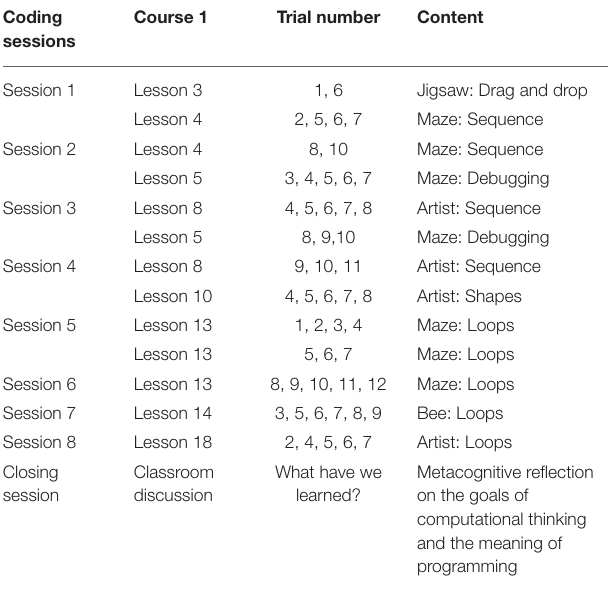
TABLE 2 | Lessons plan. Selected coding games from programma il futuro, Course 1 (https://programmailfuturo.it/come/primaria/vecchie-lezioni-